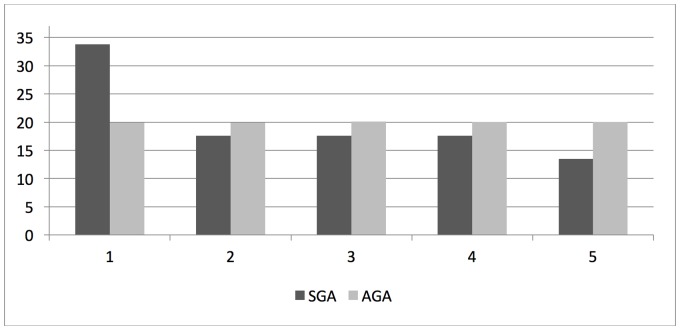
Rates (%) of TREC values in quintiles (1 = lowest quintile) in infants with low (SGA) and appropriate (AGA) birth weights for gestational age, respectively.(Chi-square p-value = 0.05).